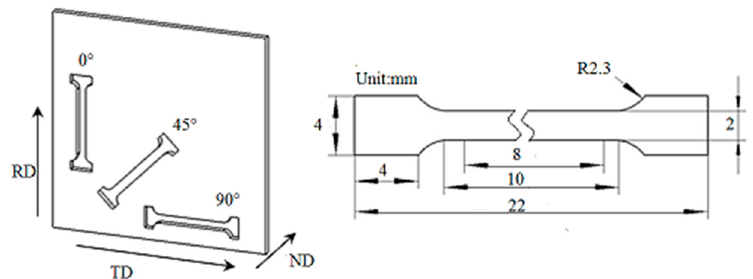
Figure 2. Sampling positions and dimensions of the tensile specimens.